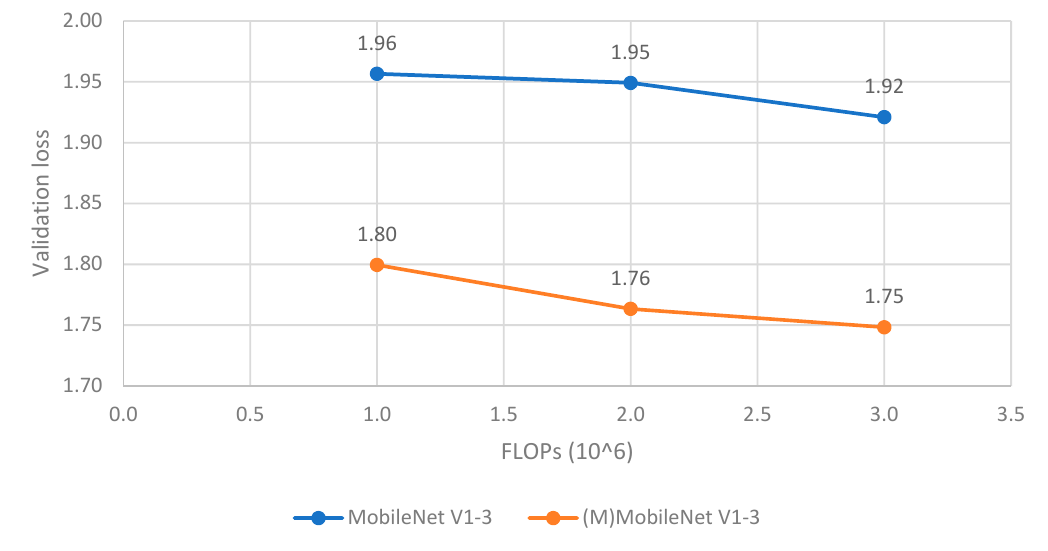
Figure 13. Comparison between EfficientNet and (M) EfficientNet (B0–B4, left to right, respectively).